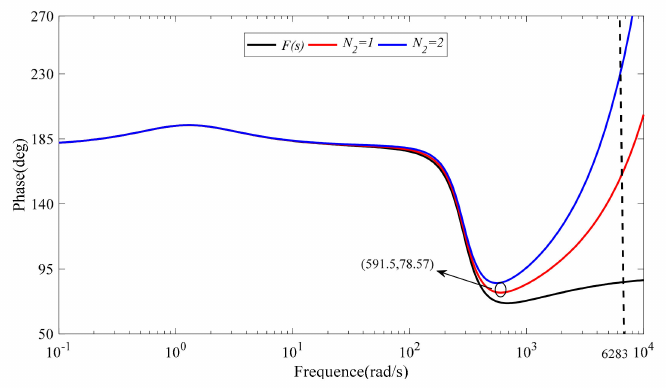
Figure 10. Bode plot of F ( s ) e T 2 s